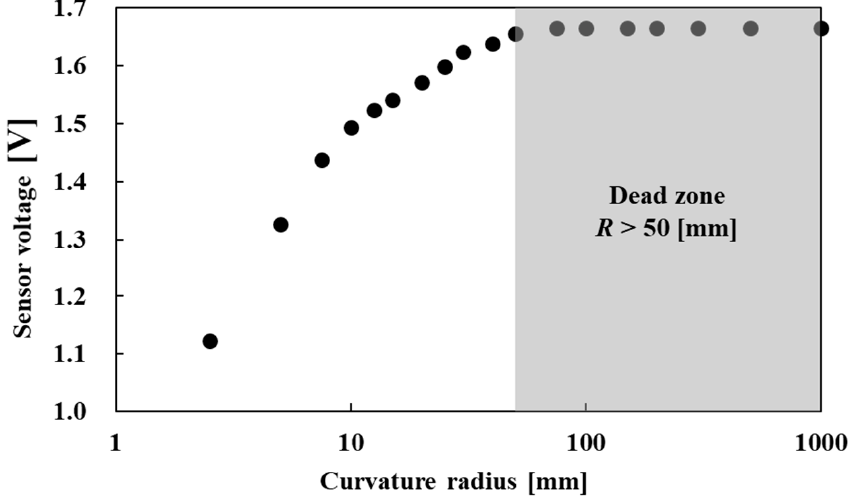
Figure 8. Relationship between the curvature radius and sensor voltage.